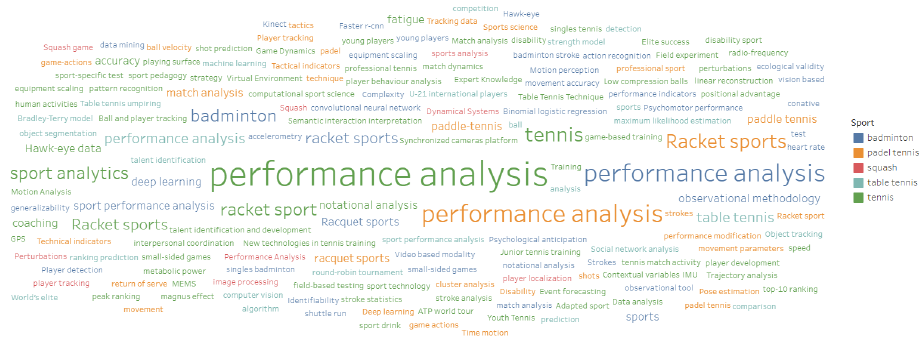
Figure 7. Keyword analysis based on the frequency for a specific racket